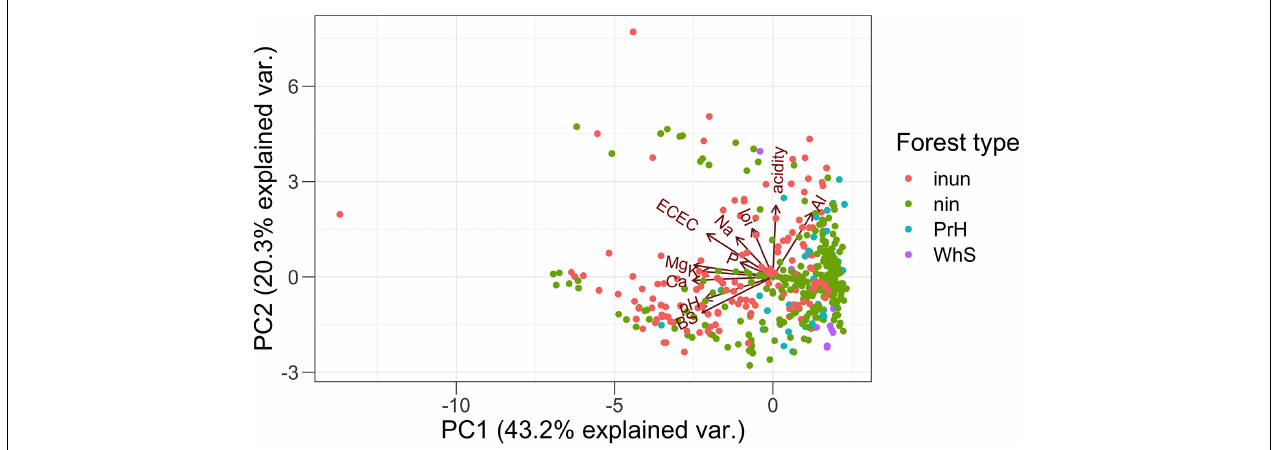
FIGURE 3 | PCA of environmental variables in the 458 transects in western Amazonia. local environmental variables : inun, inundated forest; nin, non-inundated forest; PrH, premontane hills; and WhS, white sand forest. Soil variables : pH, loi, loss-on-ignition; Al, aluminum concentration; K, Potassium concentration; acidity, exchangeable acidity; BS, base saturation; Ca, Calcium concentration; Na, Sodium concentration; P, Phosphorus concentration; ECEC, effective cation exchange capacity; and Mg, Magnesium concentration.